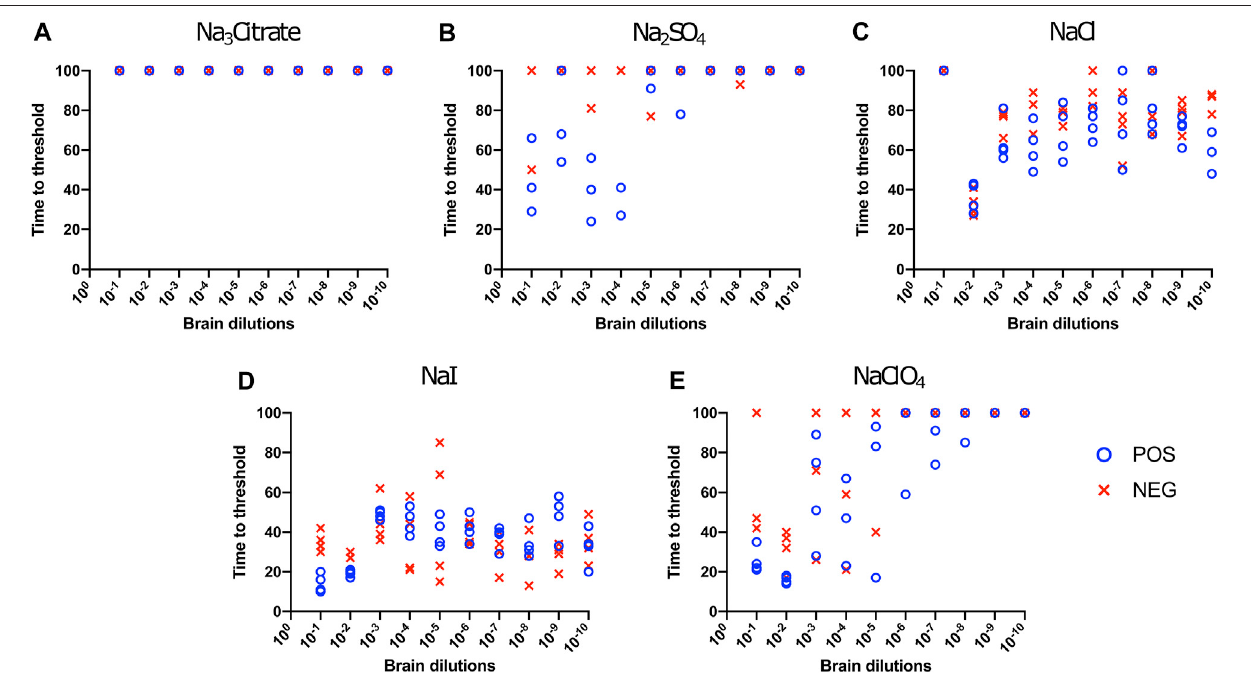
FIGURE3| Hofmeister ion effects on RT-QuIC reactions seededwith CWD-positivewhite-tailed deer brains using bovine rPrP substrate.RT-QuICreactions were seeded with 10 − 1 , 10 − 2, 10 − 3 , 10 − 4, 10 − 5 , 10 − 6 , 10 − 7 , 10 − 8 , 10 − 9 , and 10 − 10 dilutions of the brain homogenate from one CWD-positive and one CWD-negative white- tailed deer with the addition of 0.001% of SDS. Substrate contained bovine rPrP and 400 mM Na 3 citrate (A) , Na 2 SO 4 (B) , NaCl (C) , NaI (D) , or NaClO 4 (E) . Reactions were run at 42 °